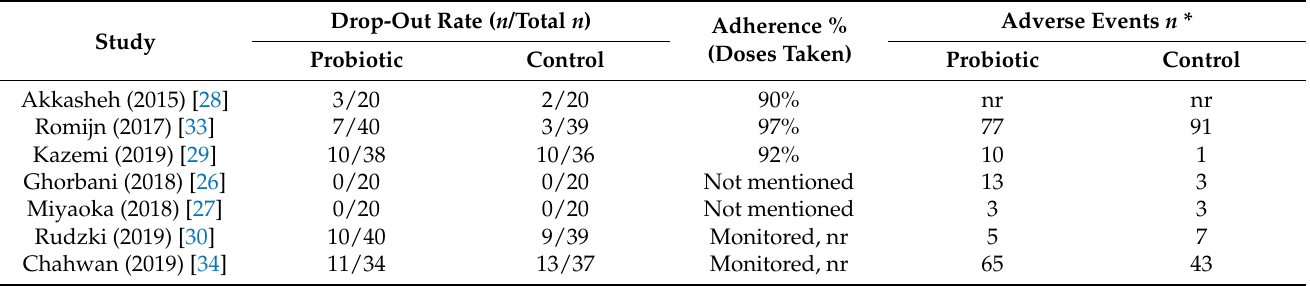
Table 3. Drop-out, tolerability, and compliance rates in the included